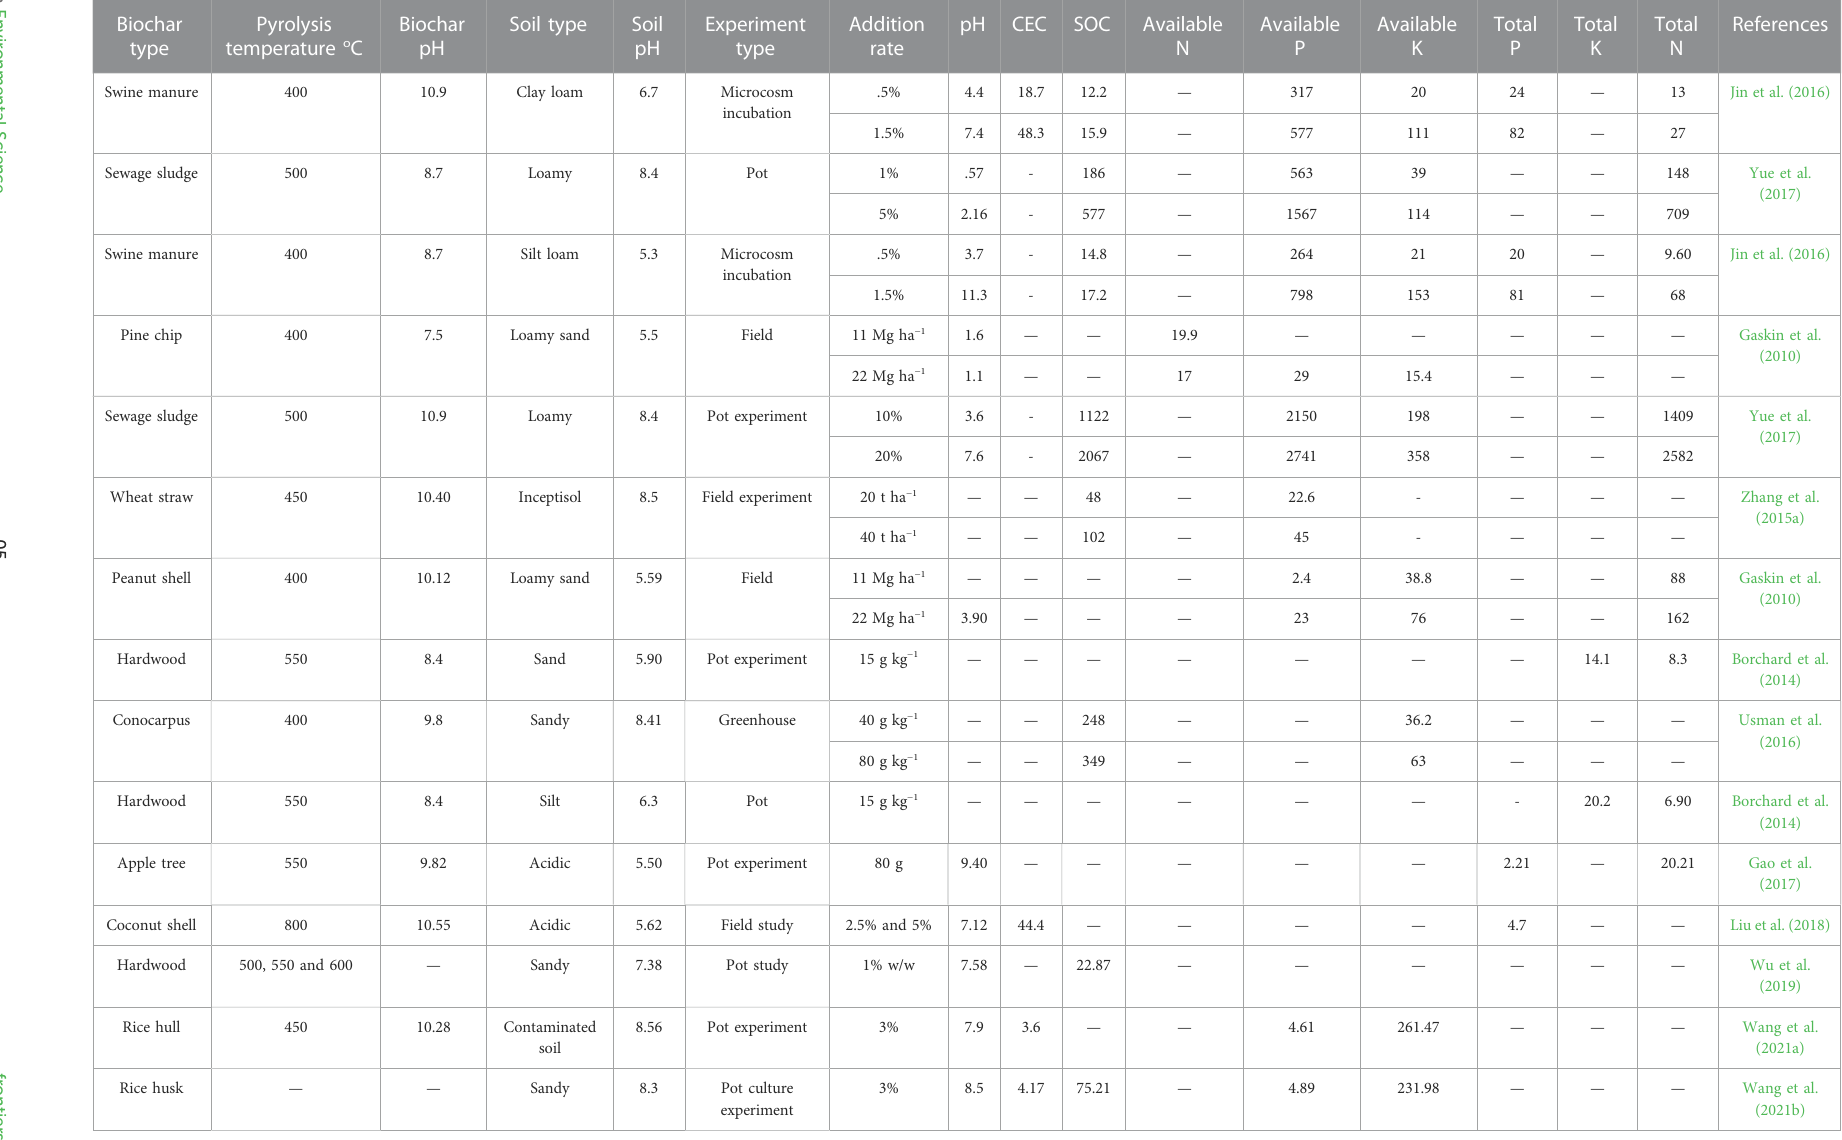
TABLE 2 Effect of biochar addition on the soil chemical attributes (% change compared to control). Biochar type